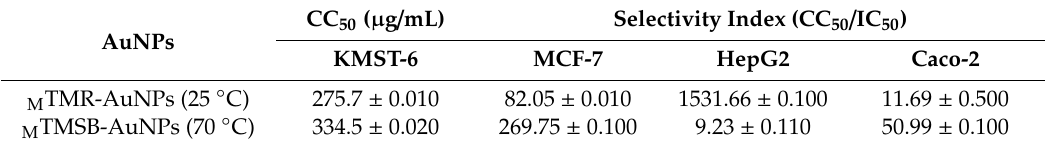
Table 6. Cytotoxicity of selected TM-AuNPs on KMST-6 cells and their selectivity index. CC 50 ( µ g / AuNPs